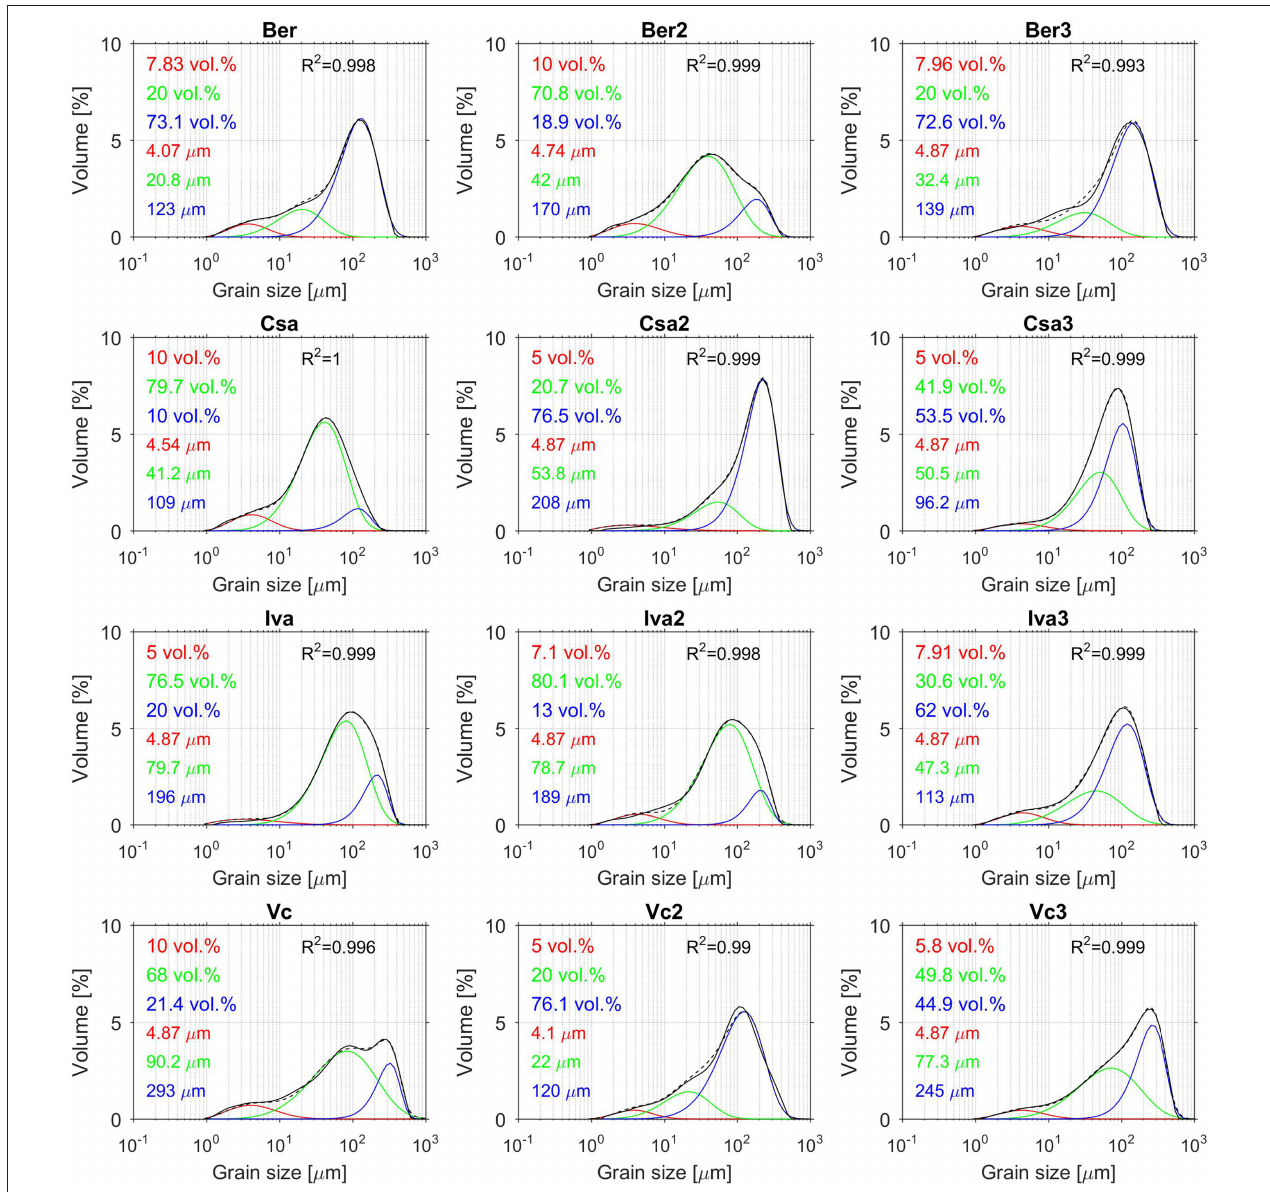
FIGURE 3 | Results of parametric curve-fitting of the measured grain-size distributions (volumetric amount and modal grain-sizes of the subpopulations are also presented). Three representative samples from the study sites are shown here. Ber, Beremend; Csa, Csarnóta; Iva, Ivanovce; Vc,